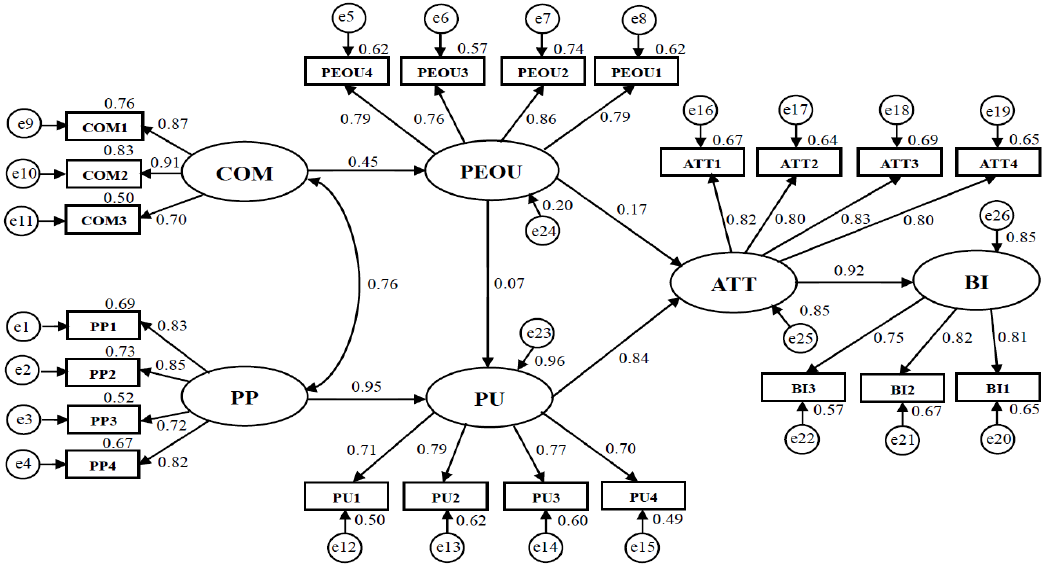
Figure 2. Switch User’s Behavior model results.